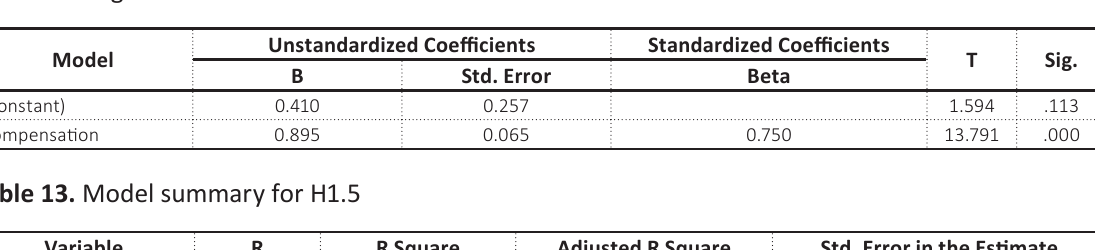
Table 12. Regression coefficients for H1.4